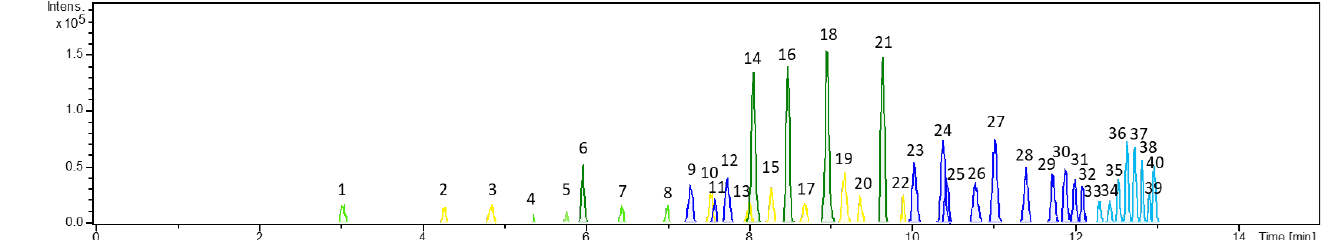
Figure 3. UHPLC-HRMS analysis of a receptor fluid after 48 h with dissect compound chromato- grams of DH hydroxides (dark green, 6: DHac-OH, 14: DHma-OH, 16: DHib-OH, 18: DHt-OH,